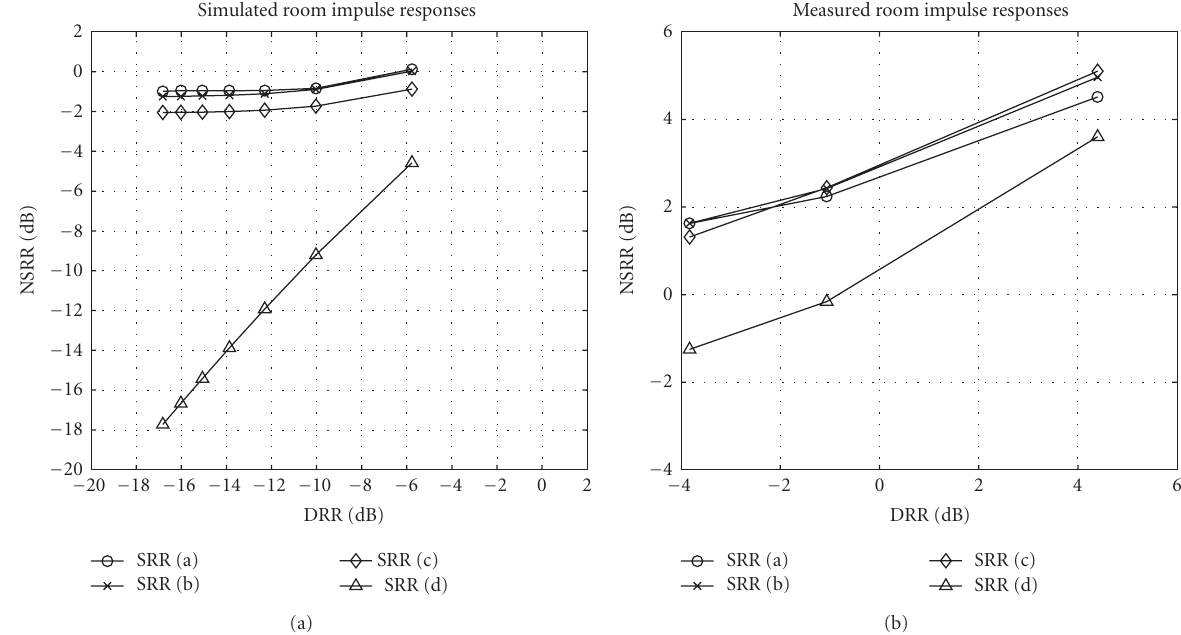
Figure 2: Comparison with DRR and NSRR calculated using (a) peak normalization, (b) RMS normalization, (c) A-weighted RMS normalization, and (d) least squares optimal